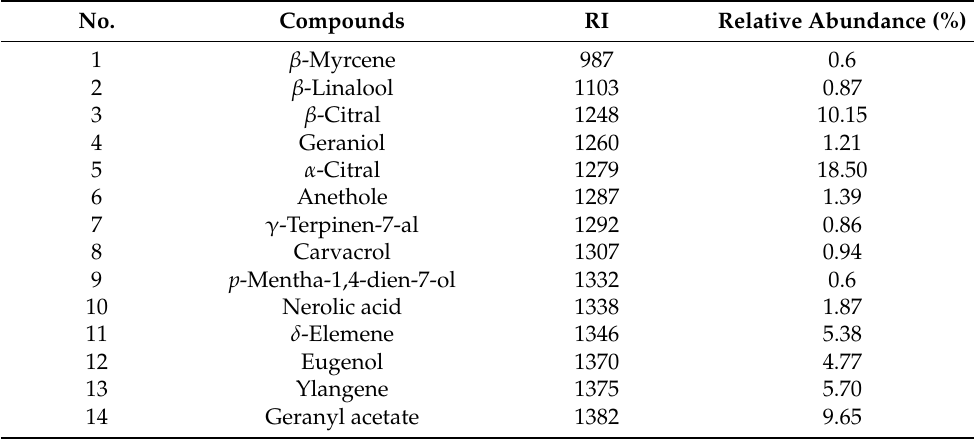
Figure 1. GC-MS profile/chromatogram of the volatile constituents identified in C. citrates essential oil. The y -axis is the relative abundance of the total ion current (TIC) and the x -axis is the retention time (min). Table 1. Volatile constituents of C. citrates.